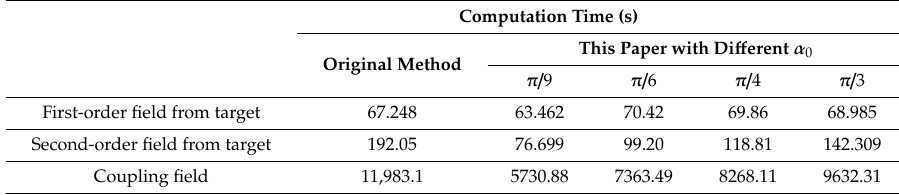
Table 2. Comparison of the calculation e ffi ciency between the proposed way and the original GO / PO